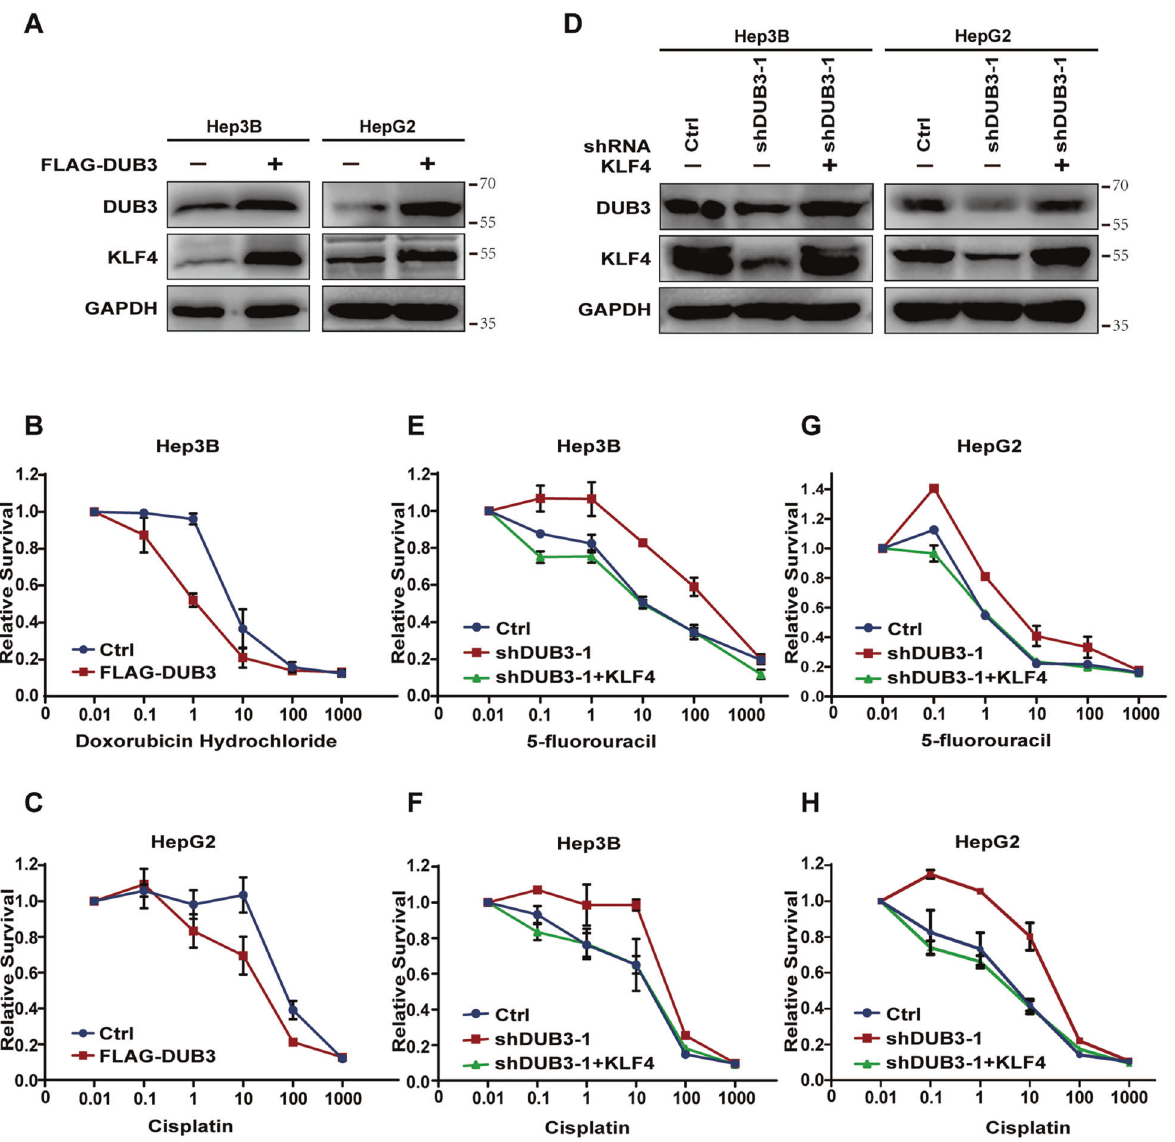
Fig. 5 DUB3 enhanced chemosensitivity of HCC cells via KLF4. Hep3B and HepG2 cells were transiently transfected with the plasmids as indicated. A , D Western blot analysis was performed to determine protein expression of DUB3 and KLF4. B , C , E – H The transfected Hep3B and HepG2 cells were treated with different doses of hydrochloride, 5- fl uorouracil, or cisplatin for 48 or 72 h. CCK-8 assay was conducted to measure cell viability. Data are expressed as the mean ± SEM. * P < 0.05, ** P < 0.01, *** P < 0.001, vs. Ctrl; n =